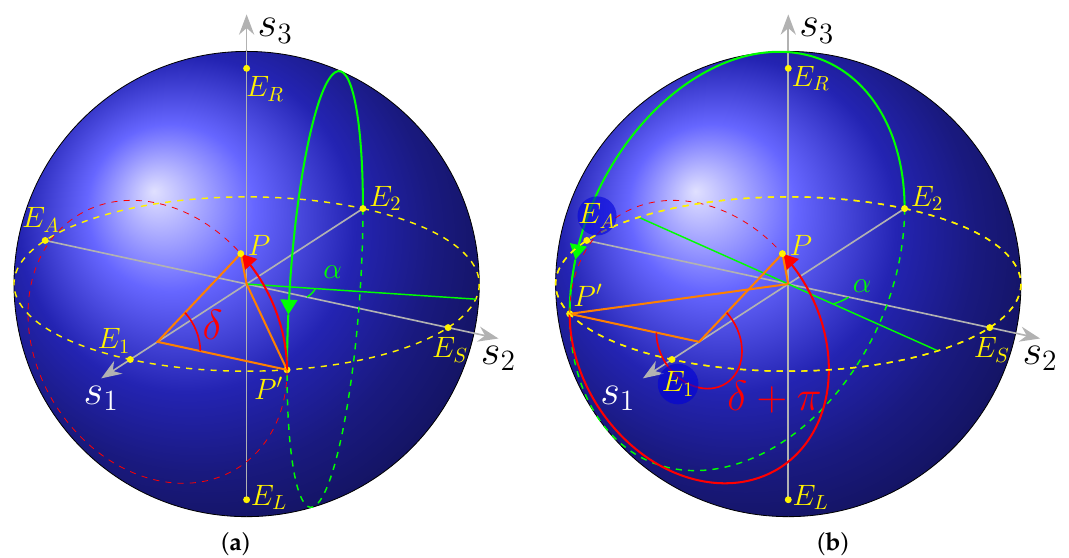
Figure 14. Action on SOP of the circuit, seen as a MZI followed by a phase shifter, for 2 α = 40 ◦ , δ = 50 ◦ , in the case of ( a ) the first solution set; and ( b ) the second solution